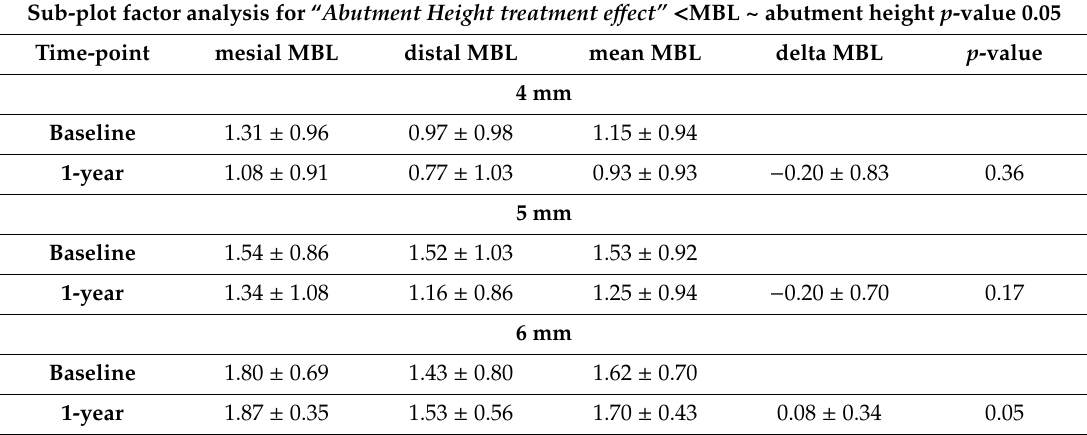
Table 3. Mean marginal bone level (MBL) by implant abutment-height by year.